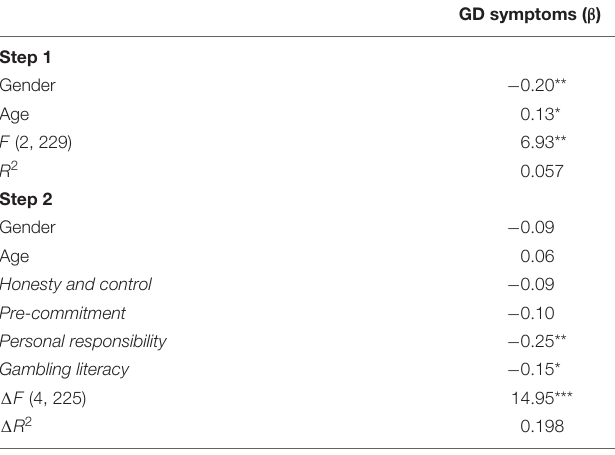
TABLE 4 | Hierarchical regression of PPS-AC predicting GD symptoms ( N =